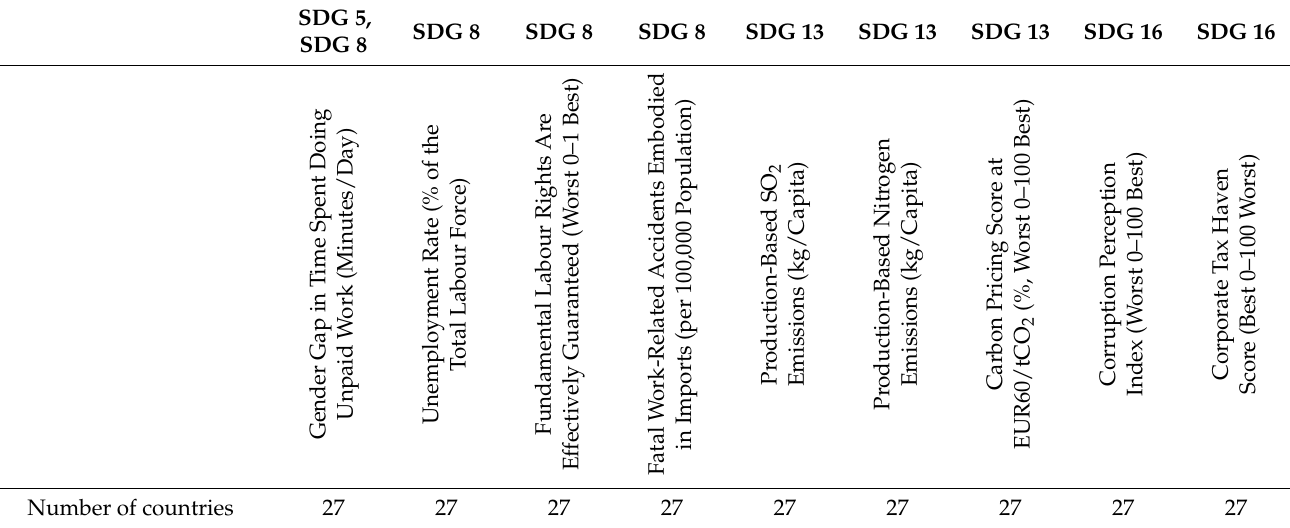
Table 5. Representation of CSR practices to support the SDGs (UN standards) in countries of E. Europe and C. Asia in